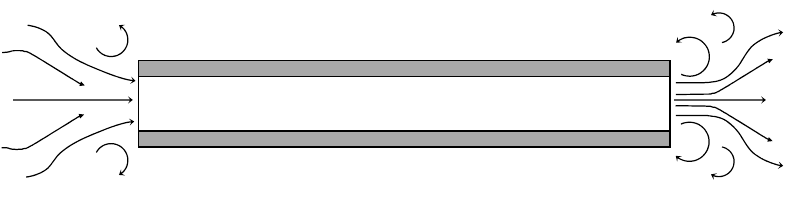
Figure 3. Flow entering and leaving a substrate channel.